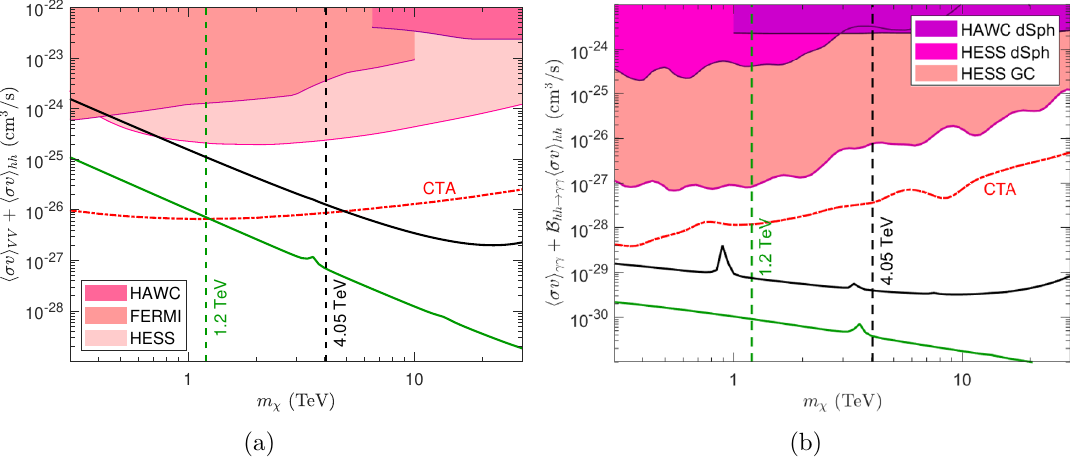
Figure 14. (Left 14(a)) The total predicted annihilation cross-section into pairs of gauge vectors and Higgs bosons for the complex doublet (green) and the quartet (black) at the threshold coupling values of λ 0 / Λ = 10 − 3 GeV − 1 and λ c / Λ = 3 × 10 − 6 GeV − 1 . The astronomical background data about the Galactic diffuse emission is identical to that of figure 9(b). (right 14(b)) The theoretical cross-section into prompt gamma-ray lines plus the contribution from the Higgs annihilation into monochromatic photons for the same non-renormalisable coupling strength. The astrophysical information on experimental line probes is the same as figure